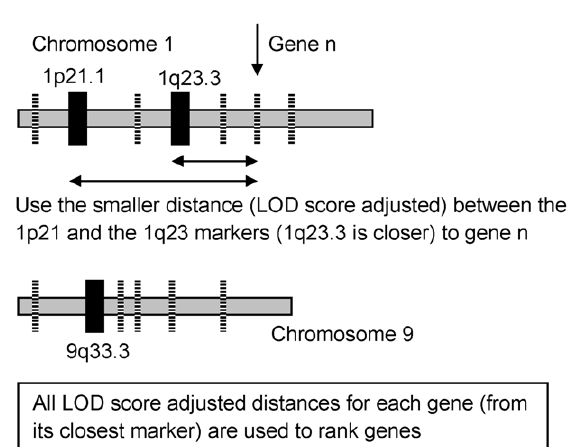
Figure 6. The rationale behind LoGS. In this figure, we use two loci to illustrate how LoGS works. Say Chromosome 21 has two loci that by their genetic distance from the closest locus on that chromosome (for example the gene between loci 1p21.1 and 1q23.3 is closer to 1q23.3 and thus its distance from 1q23.3 is used). This ranking for all chromosomes (in this example chromosomes 1 and 9) is then